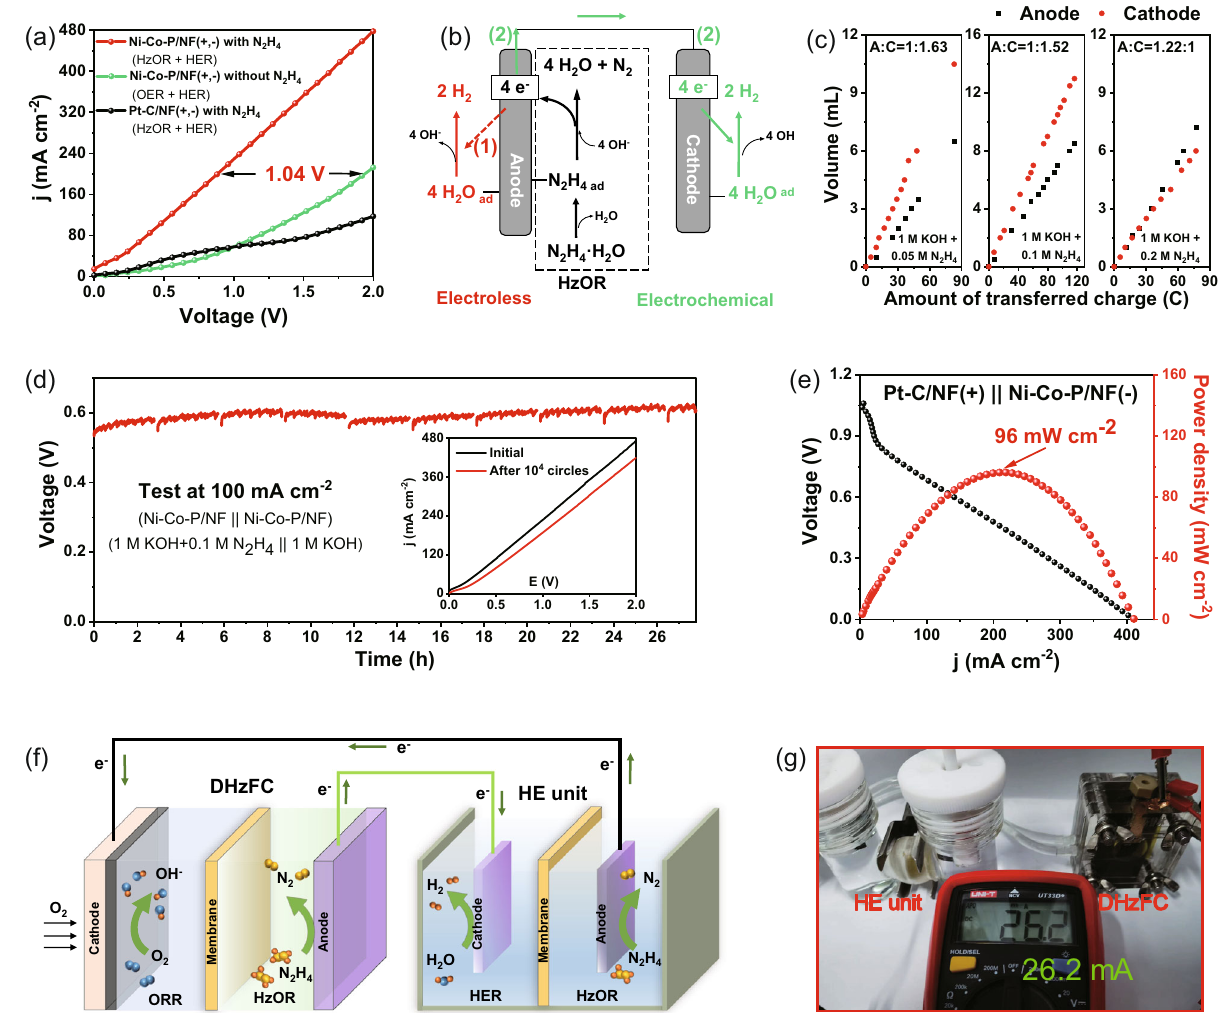
Fig. 6 | Electrochemical propertiesofthe HEunit (a, b, c, d) with Ni-Co-P/NF as bothanodeandcathodecatalysts; DHzFC(e)withNi-Co-P/NFasanodeandPt- C/NF as cathode; Self-powered System (f, g). a LSV curves of the electrolyzer equippedwithdifferentelectrodecatalystsin1MKOHwithoutorwiththeaddition of N 2 H 4 at anode (without iR compensation); b The proposed competing electro- less decomposition path (red, path 1) and electrochemical path for H 2 production